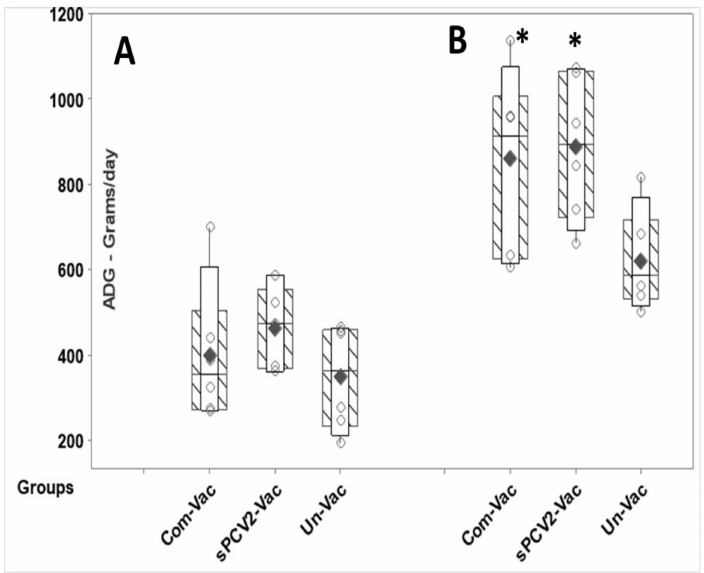
Figure 8. Weight gain in vaccinated pigs: Protection against weight loss due to challenge with the heterologous PCV2d virus is represented as the average daily weight gain (ADG). X -axis— experimental groups, Y -axis—ADG in grams per day, A —10 days post-challenge B —21 days post- challenge. Boxes with slanted lines—interquartile range, whiskers—range, unfilled vertical bar—95% confidence interval, horizontal bar—median, solid black diamonds—mean, circles—individual values. * Significantly different from the unvaccinated control group by the Student’s t -test at p ≤ 0.05. No significant differences were observed between the commercial vaccine group and test vaccine group at both time points